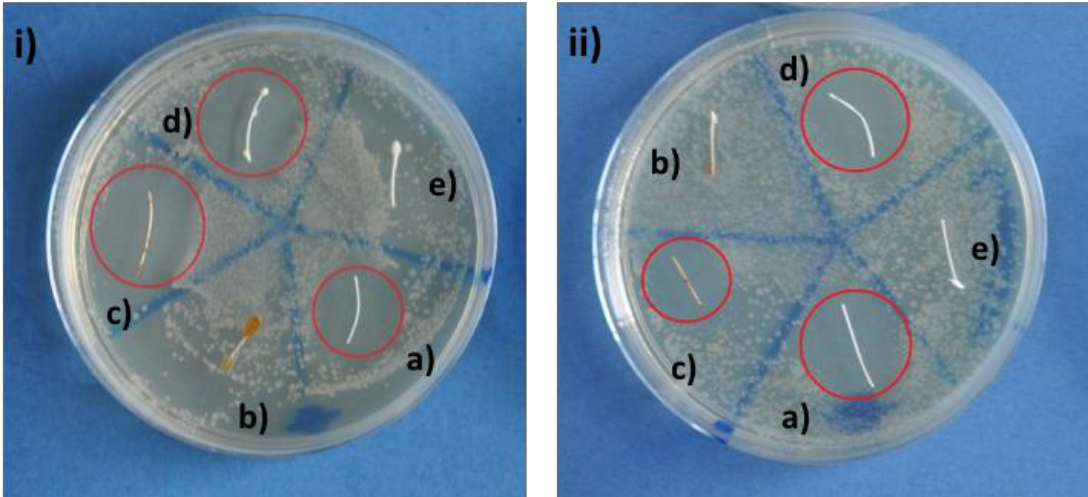
Figure 4. Agar-disk diffusion test with i ) Gram-positive (S. carnosus) and ii ) Gram-negative (E. coli) bacteria with a ) uncoated VICRYL ® Plus, b ) PCL/Ag-MBG, c ) chitosan/Ag-MBG, d ) chitosan/Zn-BG, and e ) PCL/Zn-BG.